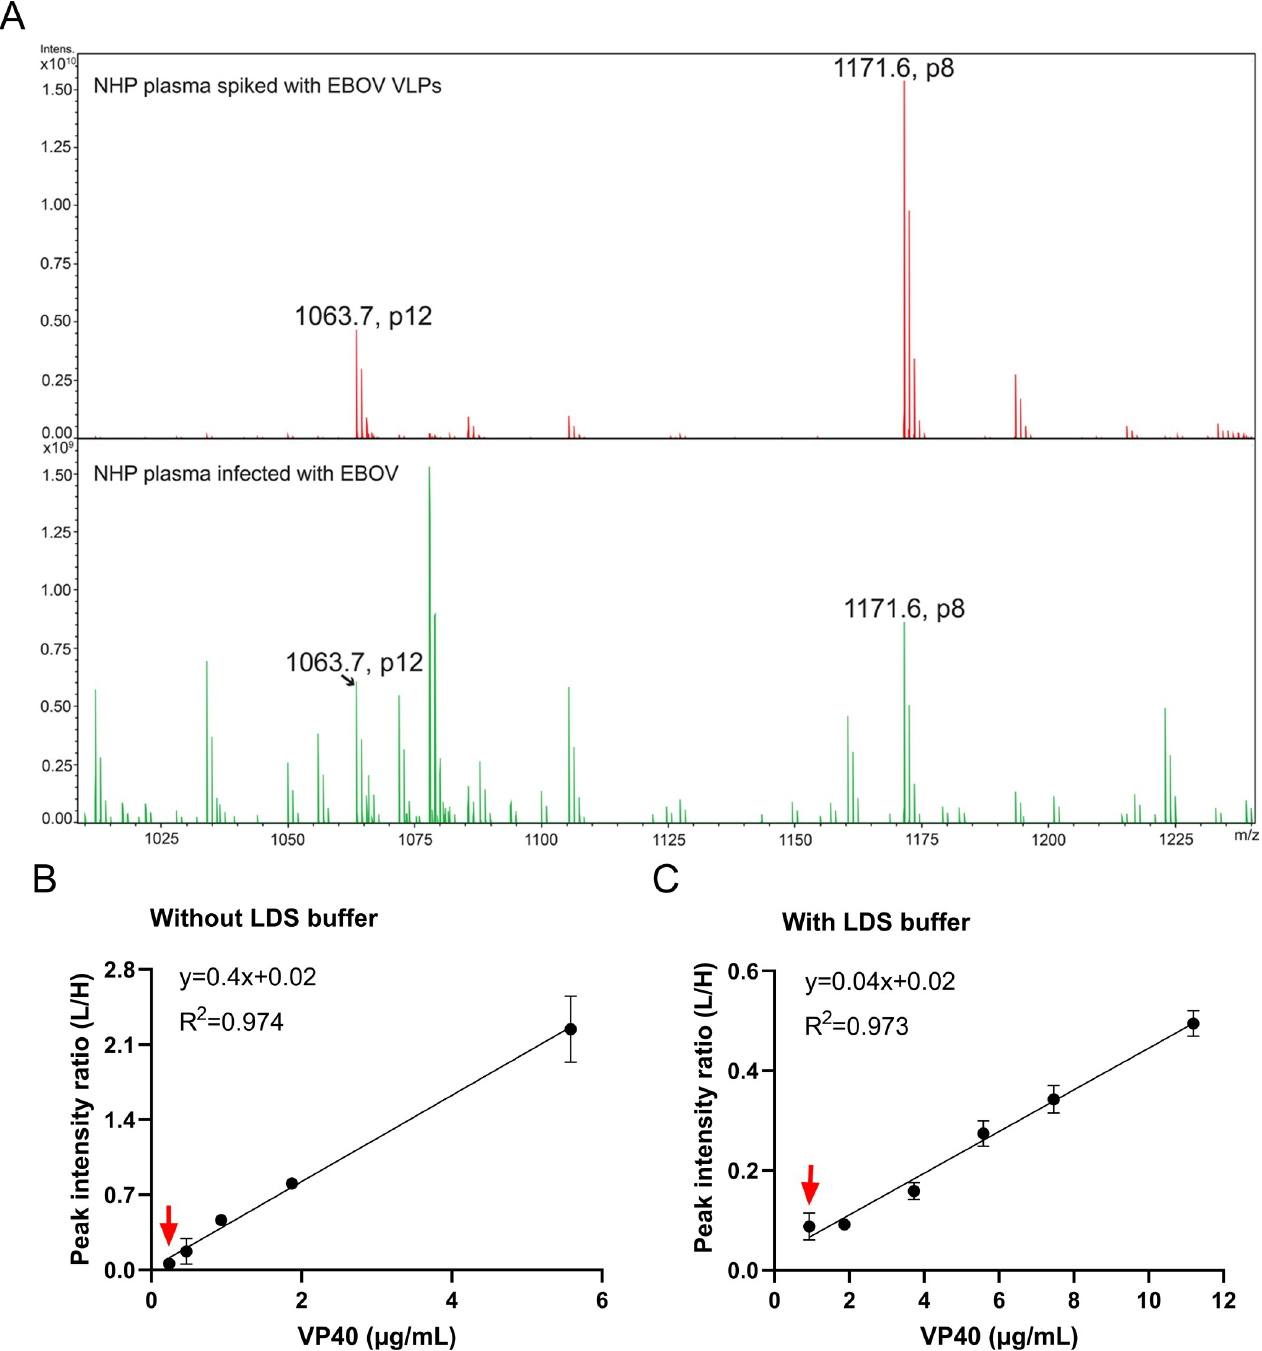
Fig 6. Species identification and VP40 quantitation in NHP plasma by IP-MALDI-MS. (A) MALDI-TOF MS spectra of IP enriched peptides from (upper) NHP plasma spiked with 10 μ g EBOV VLPs protein and (lower) authentic EBOV infected NHP plasma at day 7 post-infection (Animal ID 6311, viral titer 7.91 × 10 9 GEq/mL). For simplicity, only the two peptide target peaks were indicated with their mass-to-charge ratio (m/z). (B-C) Internal standard (IS) of EBOV VP40 peptide 8 was spiked into the plasma after digestion for VP40 quantitation. Quantitative standard curves of MS peak intensity ratios between the light (endogenous peptide) and heavy (internal standard peptide) VP40 peptide 8 and the amount of (B) recombinant protein and (C) VLP proteins spiked into NHP plasma. The data is shown as mean with standard deviation (n = 3). Red arrows indicate the assay LOD as 240 or 930 ng/mL in the absence or existence of LDS buffer,